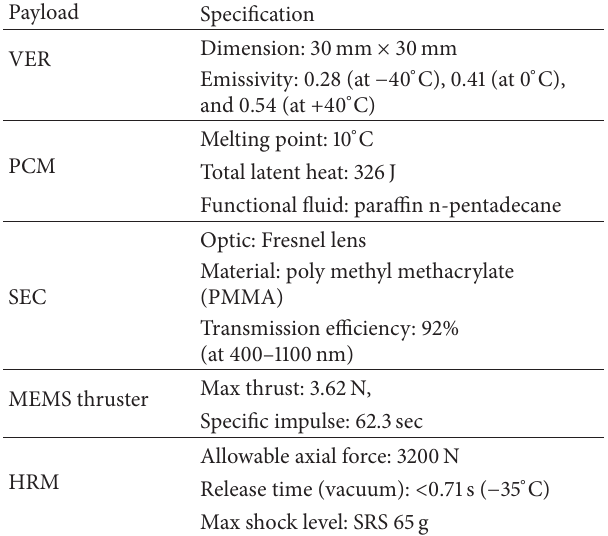
Table 3: Allowable operating temperature for STEP Cube Lab